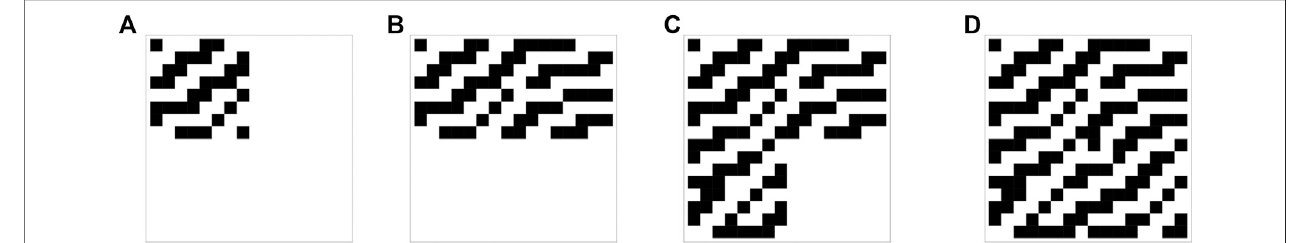
FIGURE 3 | The evolution of the center for the four steps of the greedy algorithmic information optimization method used to train the model in the fi rst experiment. This classi fi er center corresponds to class 11.